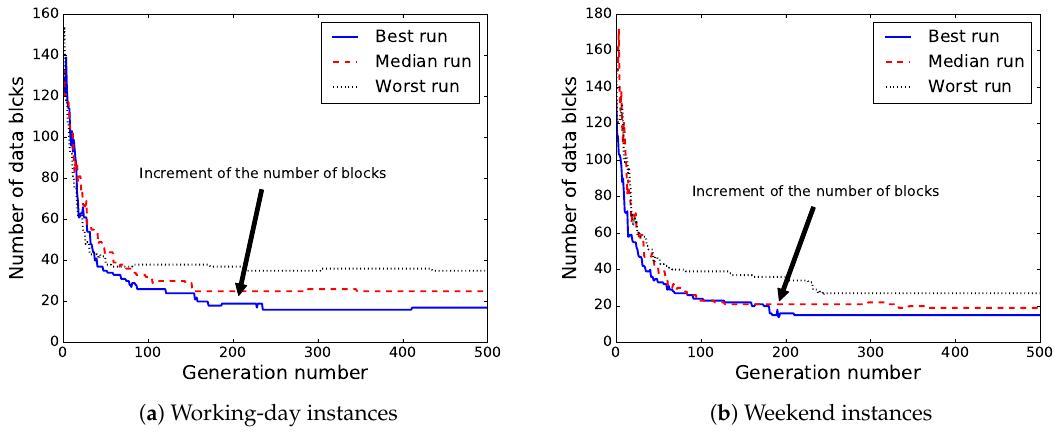
Figure 12. Evolution of the number of blocks through best, median, and worst independent